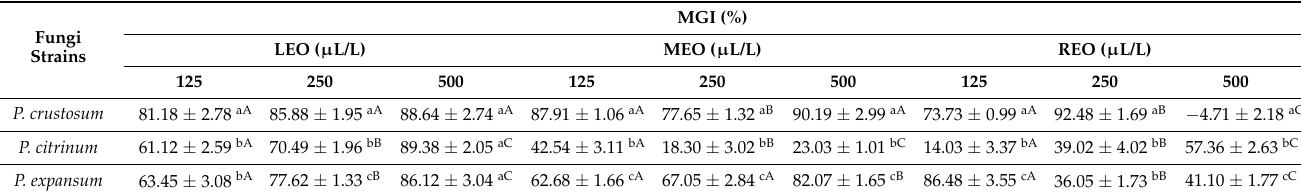
Table 7. Mycelial growth inhibition of the analysed